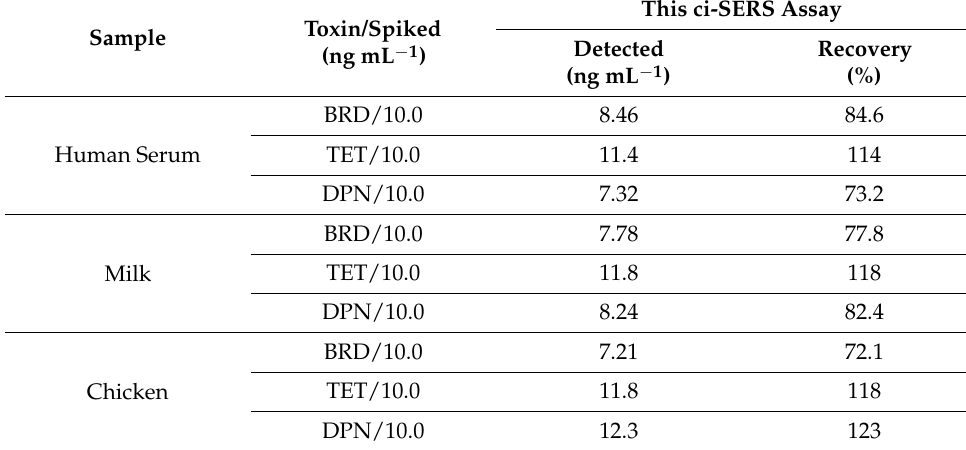
Table 1. Determination of TET, BRD and DPN in different spiked matrices using the proposed detecting strategy (data are mean value of 3